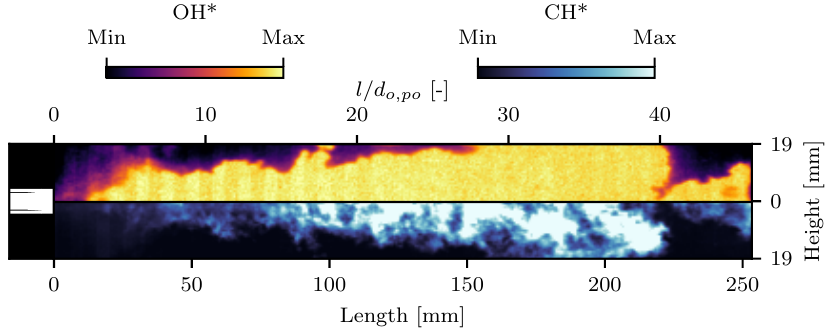
Figure 9. Instantaneous flame radiation imaging (OH*/CH*) of LP2. Figure 9, for LP2, further features an interruption with nearly diminished intensity. This implies detachment of big pockets of combustion products prior to the end of the optically accessible region.